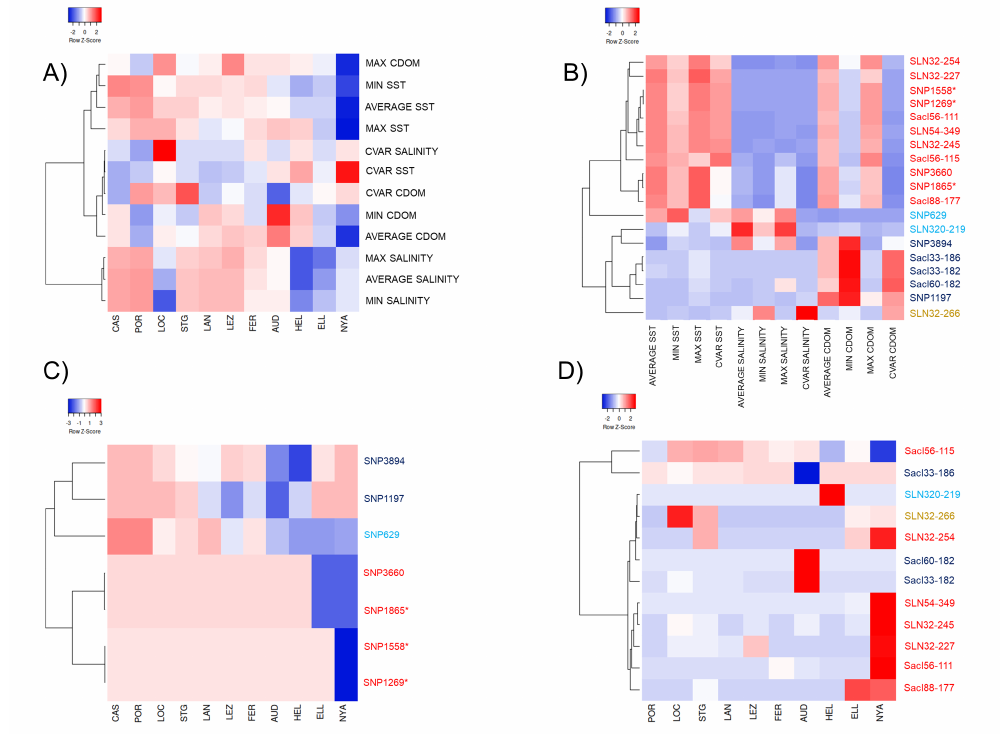
Figure 4. Heat-map graphs with co-association dendrograms for S . latissima . ( A ) Pairwise Spearman’s ρ correlations between 12 environmental parameters plotted according to their geographical variation. ( B ) Variation in the coe ffi cient of determination (R 2 ) resulting from the correlations between 19 markers (seven SNPs and 12 microsatellite alleles) and 12 environmental parameters. ( C , D ) Geographical variation in allele frequencies of ( C ) SNP, and ( D ) SSR markers shown on ( B ). The localities ( x -axis for ( A , C , D )) are ordered by latitude (a south to north gradient). In panels ( B – D ), SNP and SSR locus labels are highlighted in di ff erent colors to represent four main clusters of associations of the loci with 12 environmental parameters. Loci marked with * represent markers for which the allele frequency patterns were more likely influenced by S . latissima demography than by the selective processes (see explanation in the Material and Methods section “Test for detection of candidate outlier